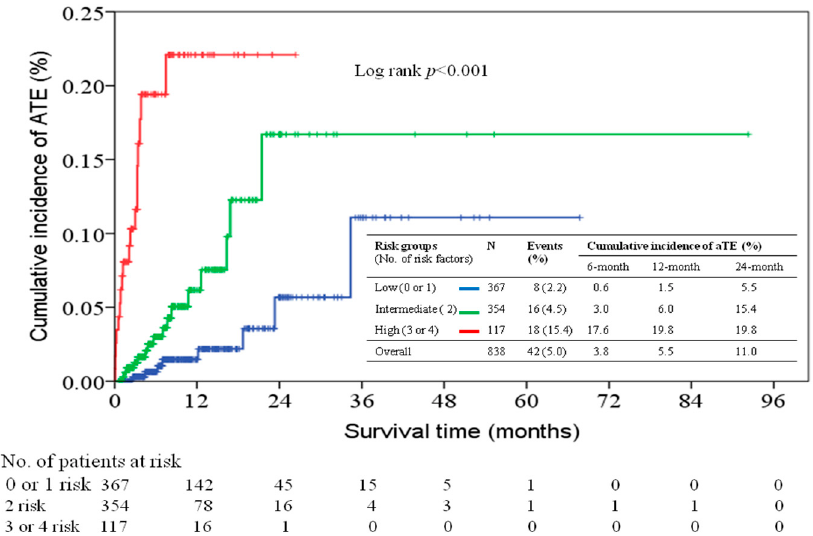
Figure 4. The cumulative incidences of development of aTE in patients in different risk groups.